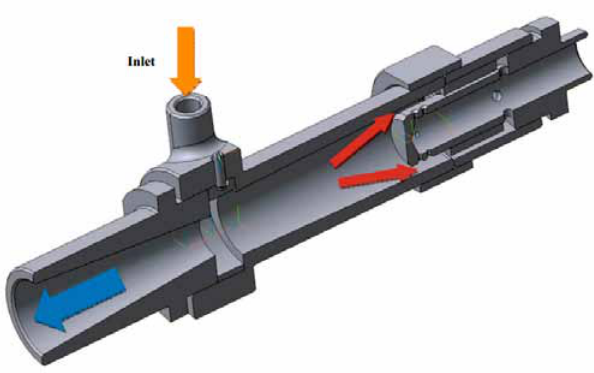
Fig. 1. A simplified plot of the vortex tube structure and the separation